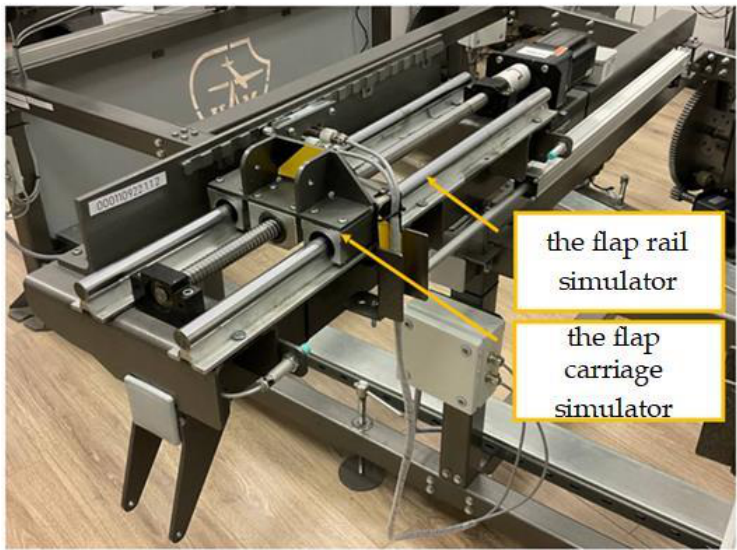
Figure 9. Flap simulator. Figure 9. Flap